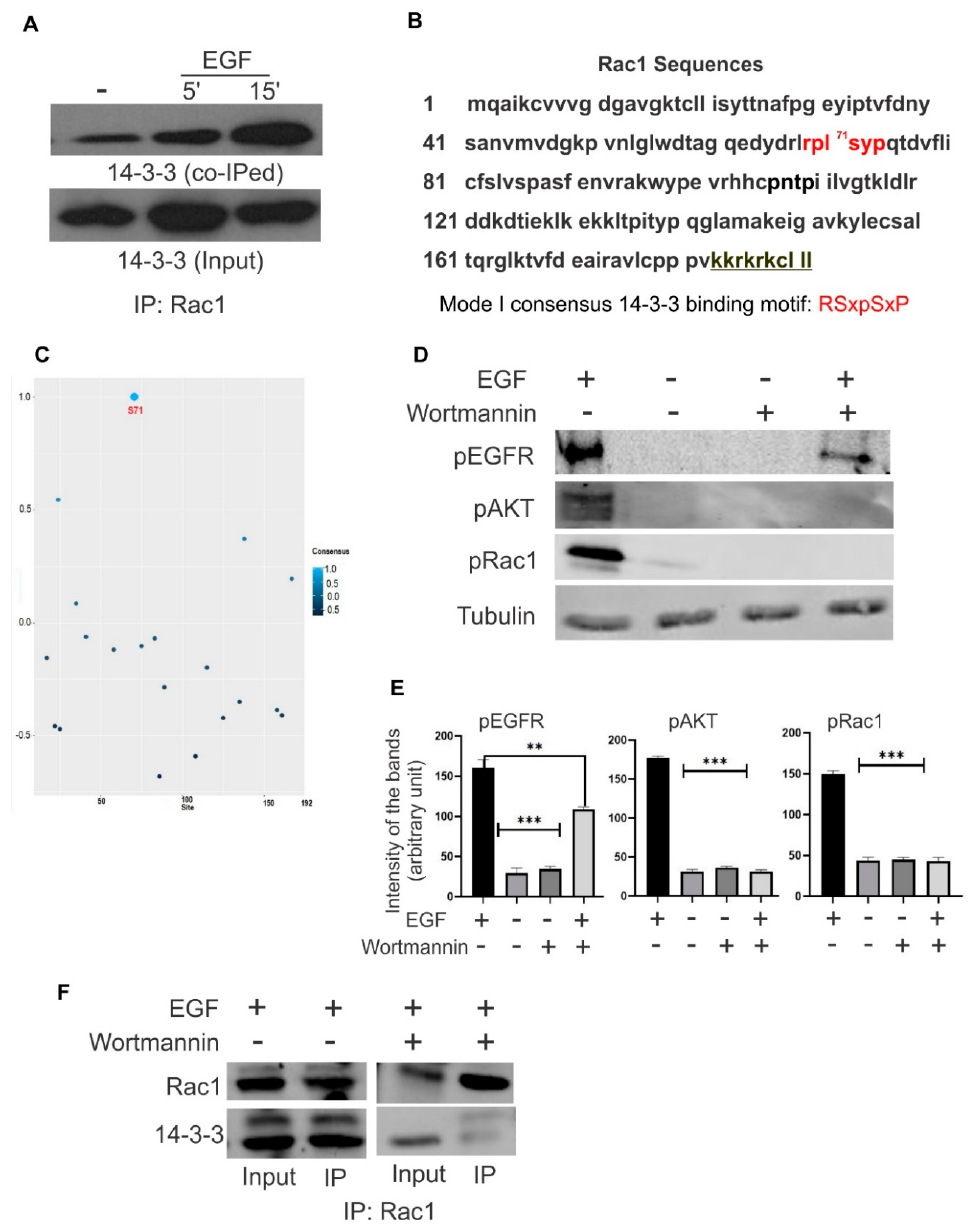
Figure 1. 14-3-3s interact with Rac1 in response to EGF in Cos-7 cells. ( A ) 14-3-3s interact with Rac1 in response to EGF in Cos-7 cells. Cos-7 cells were treated with EGF for the indicated time and the interaction between 14-3-3s and Rac1 was determined by co-immunoprecipitation (co-IP) of 14-3-3s upon immunoprecipitation (IP) of Rac1. ( B ) Sequence analysis of Rac1 reveals the presence of the mode I 14-3-3 binding motif 68 RPLSYP 73 if S71 is phosphorylated. ( C ) The highest consensus between 14-3-3 and Rac1 is within the S71-containing motif as predicted by ANN 14-3-3 Prediction software. ( D ) The effects of EGF and wortmannin on the phosphorylation of EGFR, Akt, and Rac1 S71. Cos-7 cells were treated with EGF and/or wortmannin. The phosphorylation of EGFR, Akt, and Rac S71 was revealed by immunoblotting with phospho-specific antibodies. ( E ) Quantification of the data in ( D ). The level of protein phosphorylation were quantitated by densitometry. Each value is the average of at least three experiments and the error bar is standard error. ** p < 0.01, *** p < 0.001. ( F ) The effects of EGF and wortmannin on the interaction between 14-3-3s and Rac1. Cos-7 cells were treated with EGF and / or wortmannin as indicated. The interaction between 14-3-3s and Rac1 was determined by co-IP of 14-3-3s upon IP of